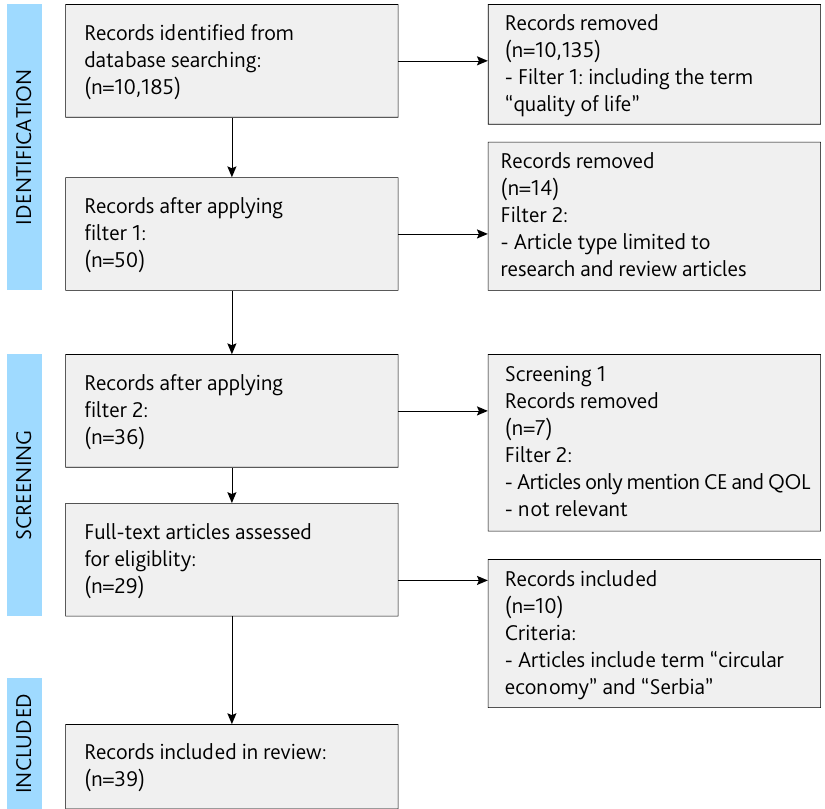
Figure 1. PRISMA flow diagram of the literature identification and review